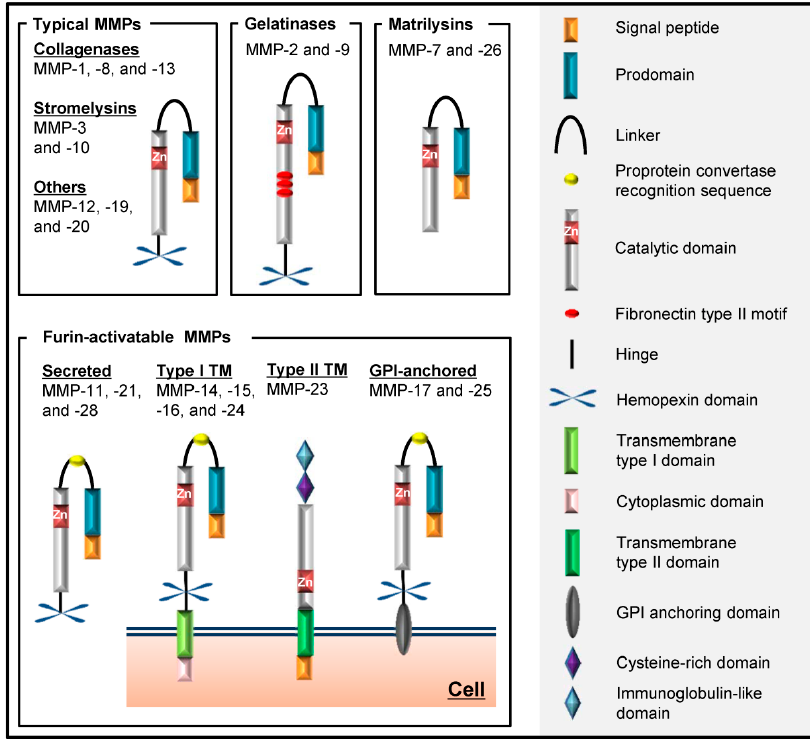
Figure 2. The schematic structures of the MMP family. Matrix metalloproteinases (MMPs) have four basic domains: the signal peptide responsible for secretion, the prodomain, which keeps the MMP inactive by coordinating the zinc ion of the catalytic site, the catalytic domain responsible for the proteolytic activity and the hemopexin domain of a propeller blade structure. The gelatinases contain three fibronectin type II repeats, which bind gelatin. Matrilysins and MMP-23 lack the hinge region and the hemopexin domain. The membrane-type MMPs (MT-MMPs) are localized on the cell surface anchored by a transmembrane (TM) domain or a glycosylphosphatidyl-inositol (GPI) anchor.